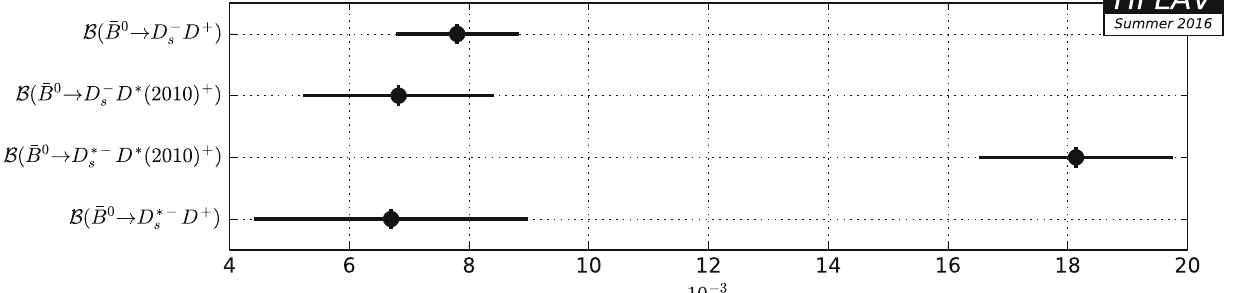
Fig. 84 Summary of the averages from Table